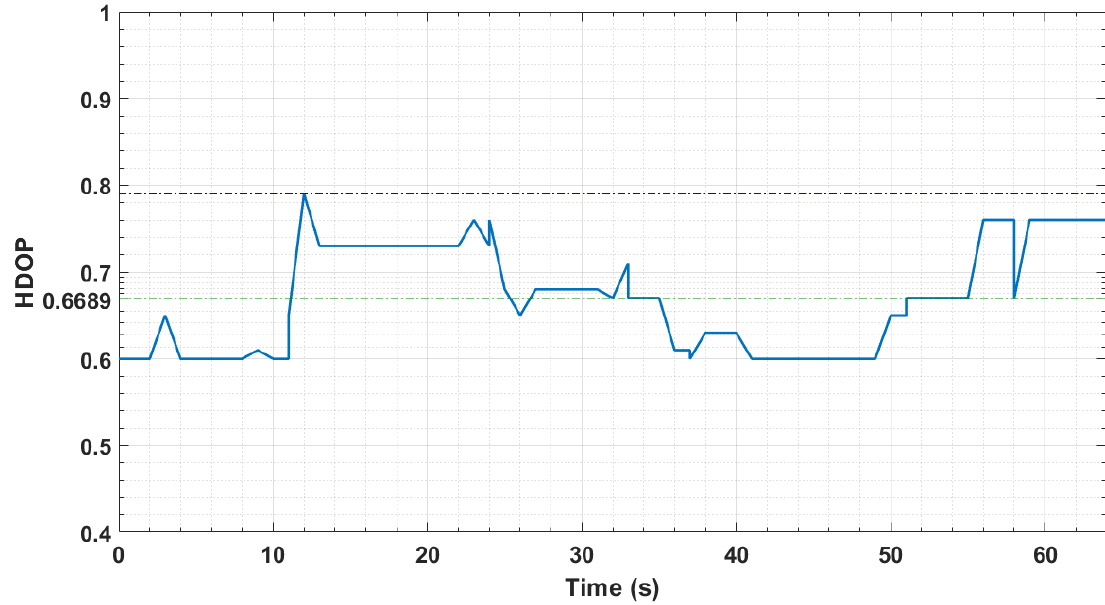
Figure 15. HDOP values versus time variables.